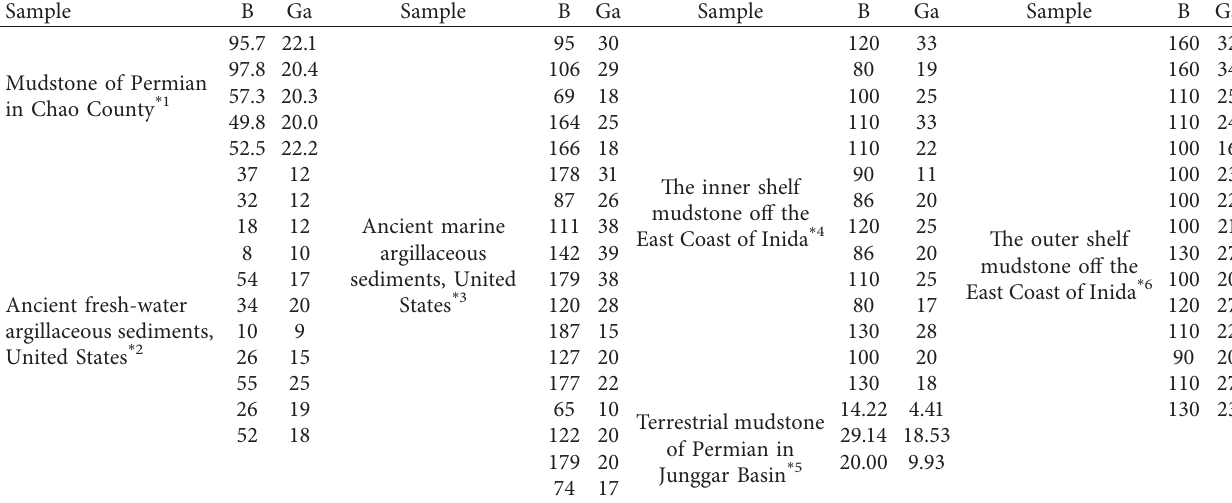
Table 5: B and Ga data of argillaceous sediments in the other places of the